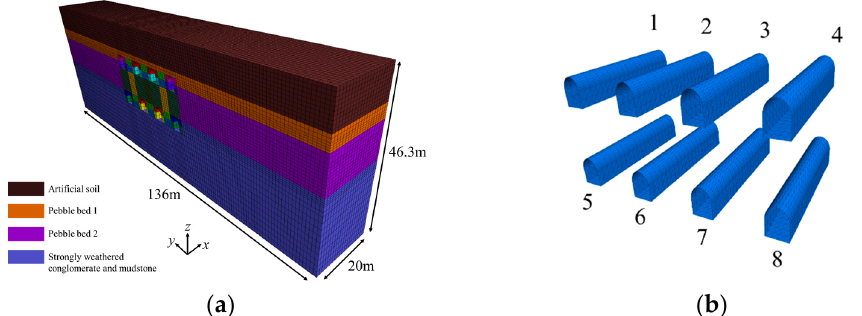
Figure 2. Numerical model: ( a ) model and ( b ) serial numbers of the pilot tunnels.